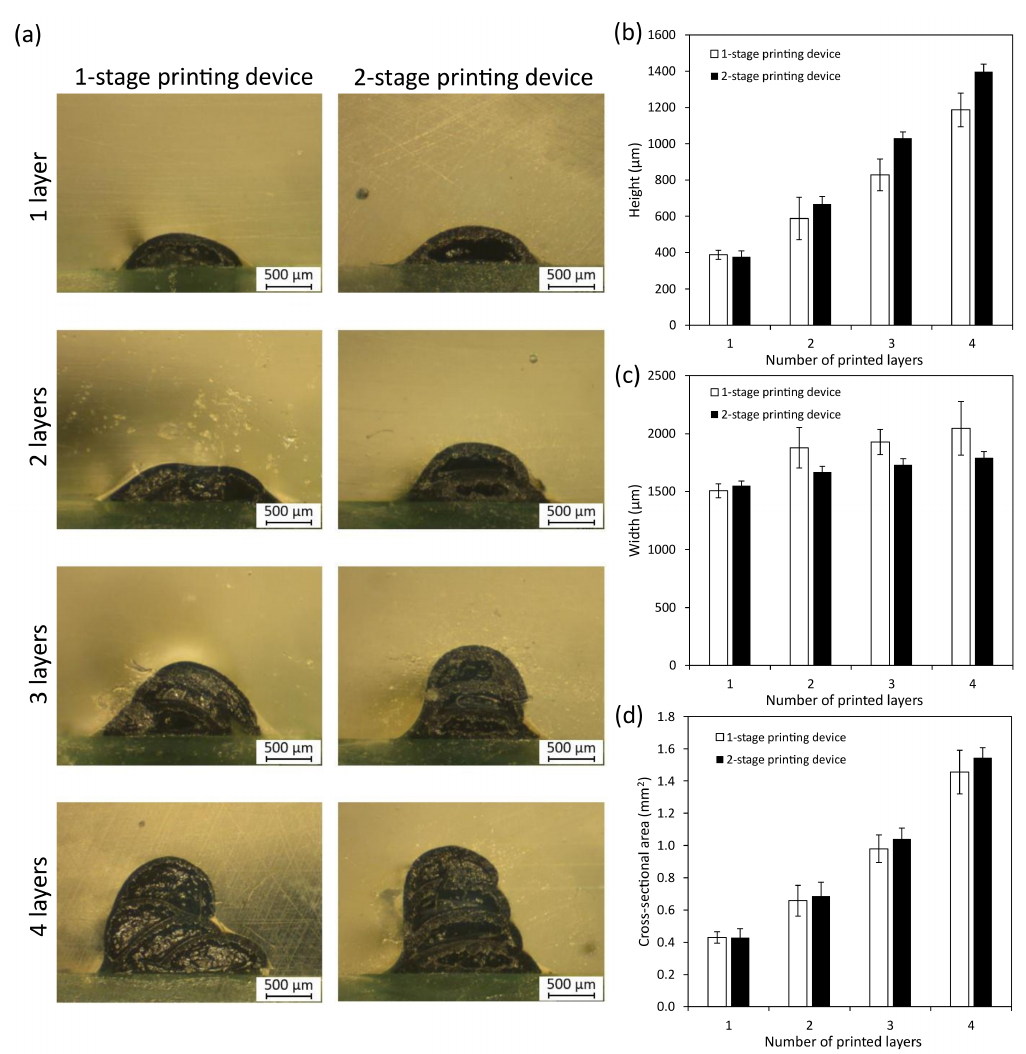
Figure 5. Morphological characterization as a function of the number of printed layers and the printed device used for housing the UV light guide. ( a ) Cross-section of the printed ribbons, ( b ) average height, ( c ) average width and ( d ) cross-sectional